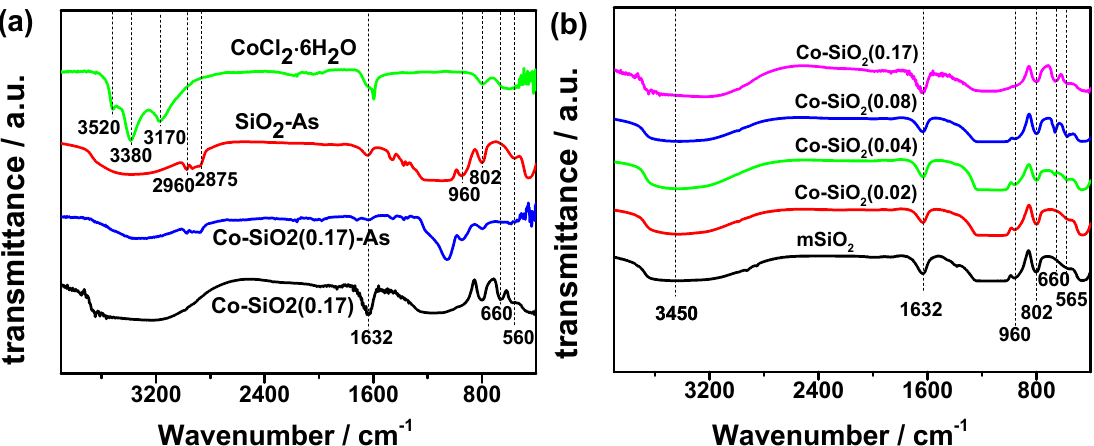
Figure 6. FTIR spectra of cobalt chloride hexahydrate; SiO 2 –As, the as ‐ synthesized Co–SiO 2 (0.17)–As; and the calcined Co–SiO 2 (0.17) ( a ); the calcined mSiO 2 and the mesoporous Co–SiO 2 ( x ) catalysts ( b